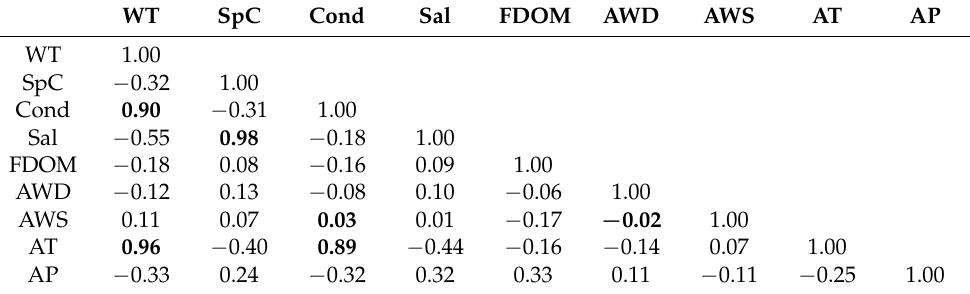
Table 2. Correlation analysis among selected variables WT, SpC, Cond, Sal, FDOM, AWD, AWS, AT, and AP in all-valid dataset, and several key correlation coefficients are shown in bold in the